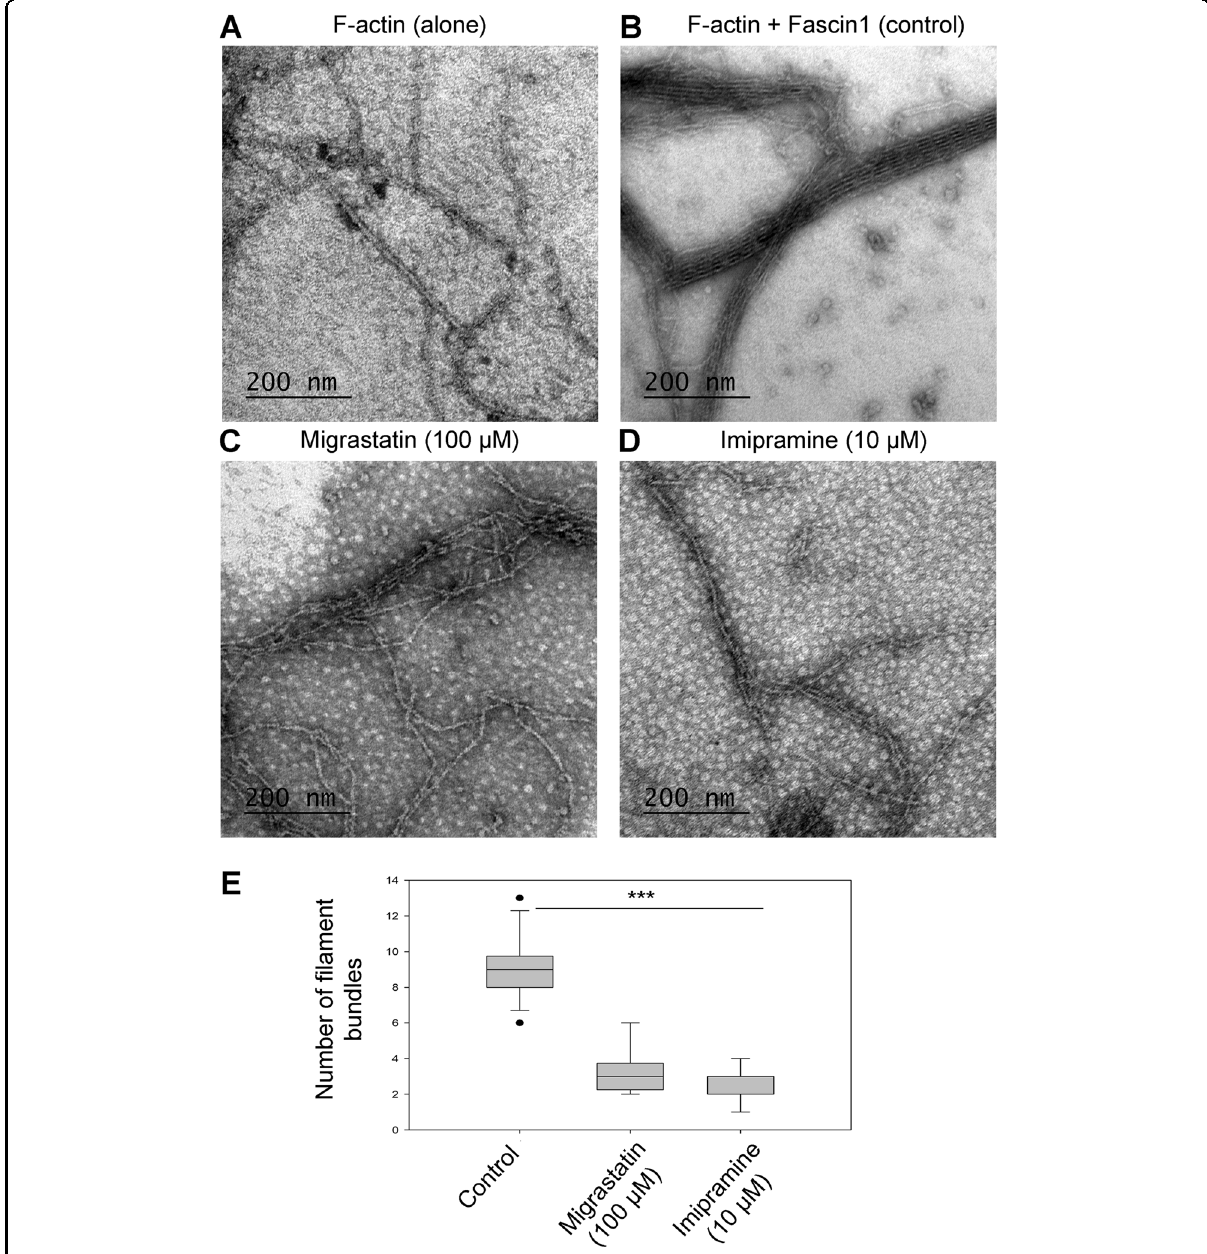
Fig. 4 TEM visualization of actin binding and bundling activities in the presence of fascin1 and inhibitors (negative staining). a Stained polymerized F-actin fi laments alone. b Under control conditions (DMSO), actin fi laments were incorporated into bundles in the presence of untreated fascin1 at a 1:1 ratio. c Binding and bundling assays with fi lamentous F-actin and fascin1 previously incubated with 100 μ M migrastatin. d Binding and bundling assays with fi lamentous F-actin and fascin1 previously incubated with 10 μ M imipramine. High-magni fi cation images (×93,000) show examples of aberrant morphology in the treated fascin1 conditions ( c , d ). e Quantitative analysis of the numbers of actin fi laments in the presence of the compounds and comparison to control conditions (*** p <